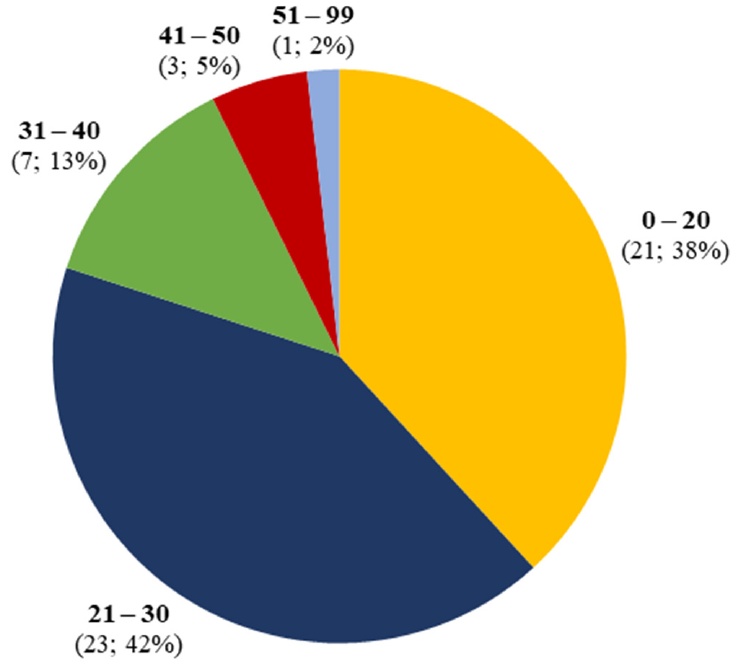
Figure 2. Age distribution of synthetic cannabinoid-induced acute kidney injury. Figure 2. Clinical presentation of synthetic cannabinoid